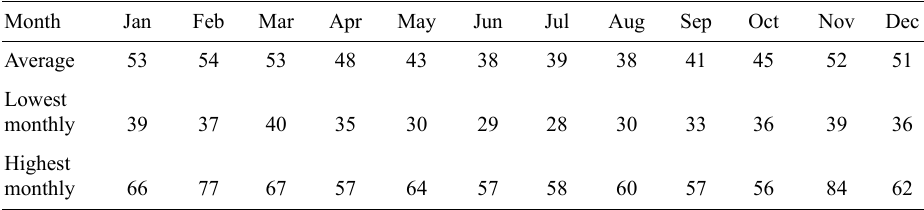
Relative humidity (%) at 14:00 SAST for the period 1978 to 2001